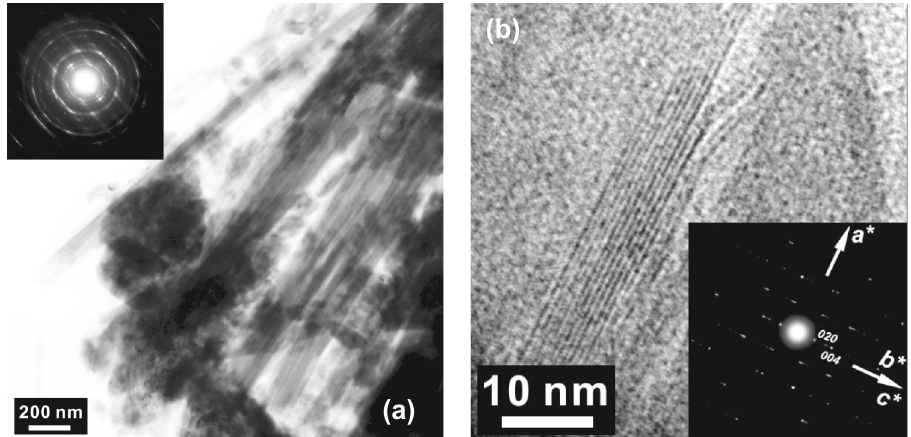
Figure 1. The characterization of the chrysotile sample. ( a ) Bright-field TEM image of fibrous chrysotile. The inset is a selected area electron diffraction (SAED) pattern from the fibrous crystals. ( b ) The high-resolution TEM image of the fibrous chrysotile showing lattice fringes of about 0.7 nm. The inset is the corresponding SAED pattern of a mixture of the [010] and [001] zone axes due to the cylindrical